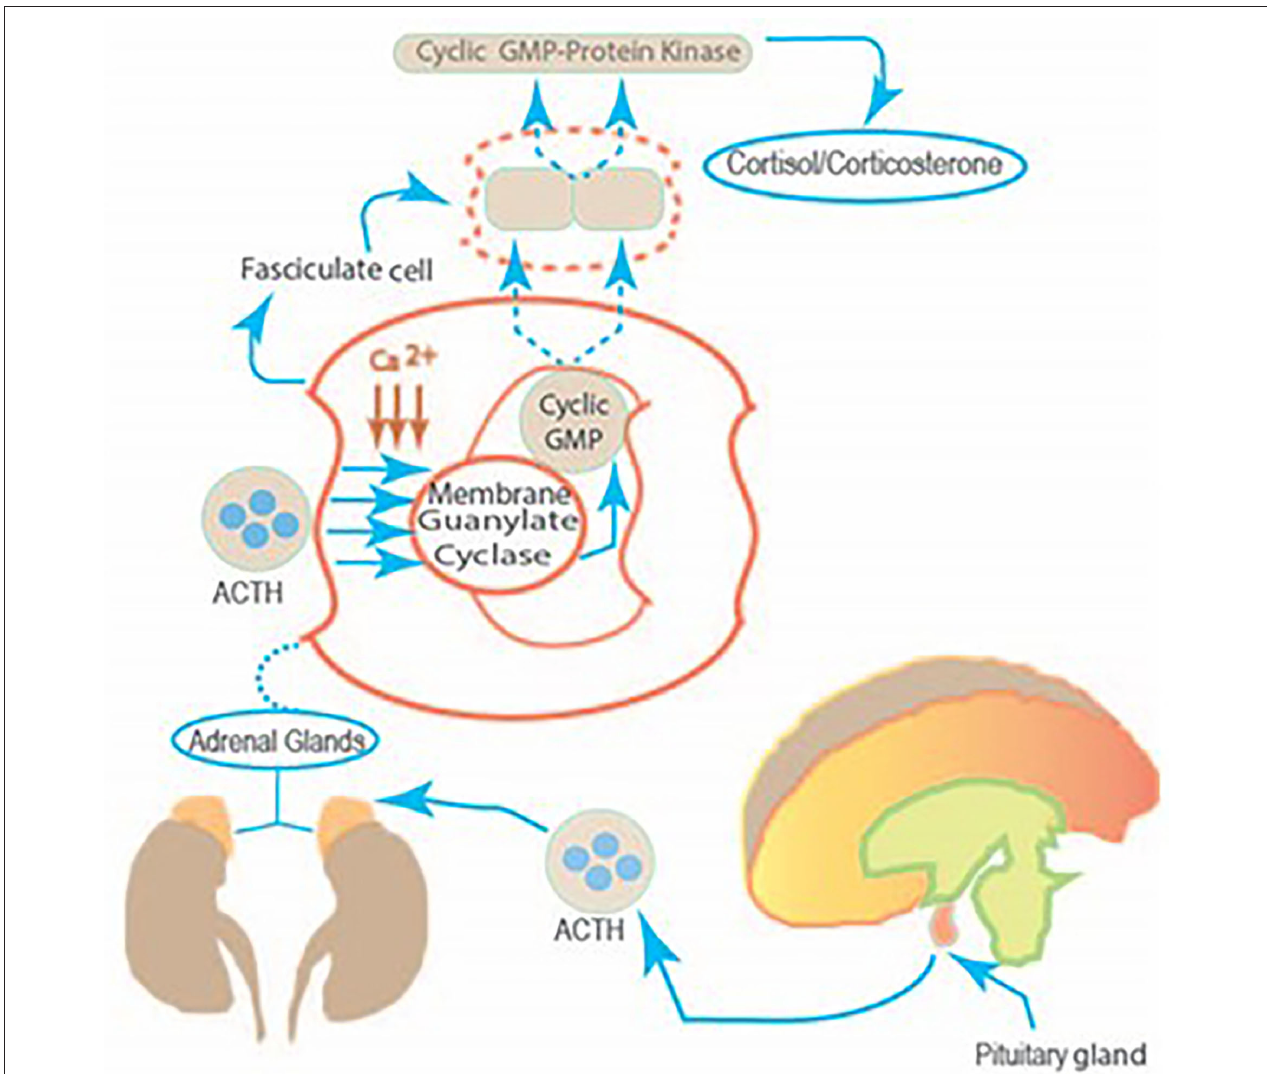
FIGURE 2 | The linkage between the pituitary gland and the fasciculate cell of the adrenal cortex. The molecular mechanism by which two ACTH co-messengers, Ca 2 + and Cyclic GMP modulate steroidogenesis. The stimulus from the corticotropin-releasing factor, generated in the hypothalamus, produces corticotropin-releasing factor (CRF) in the anterior lobe of the pituitary. Therein, CRF controls ACTH release. This, in turn, targets the fasciculate cell of the adrenal cortex, causing a chain of molecular reactions and generating cortisol